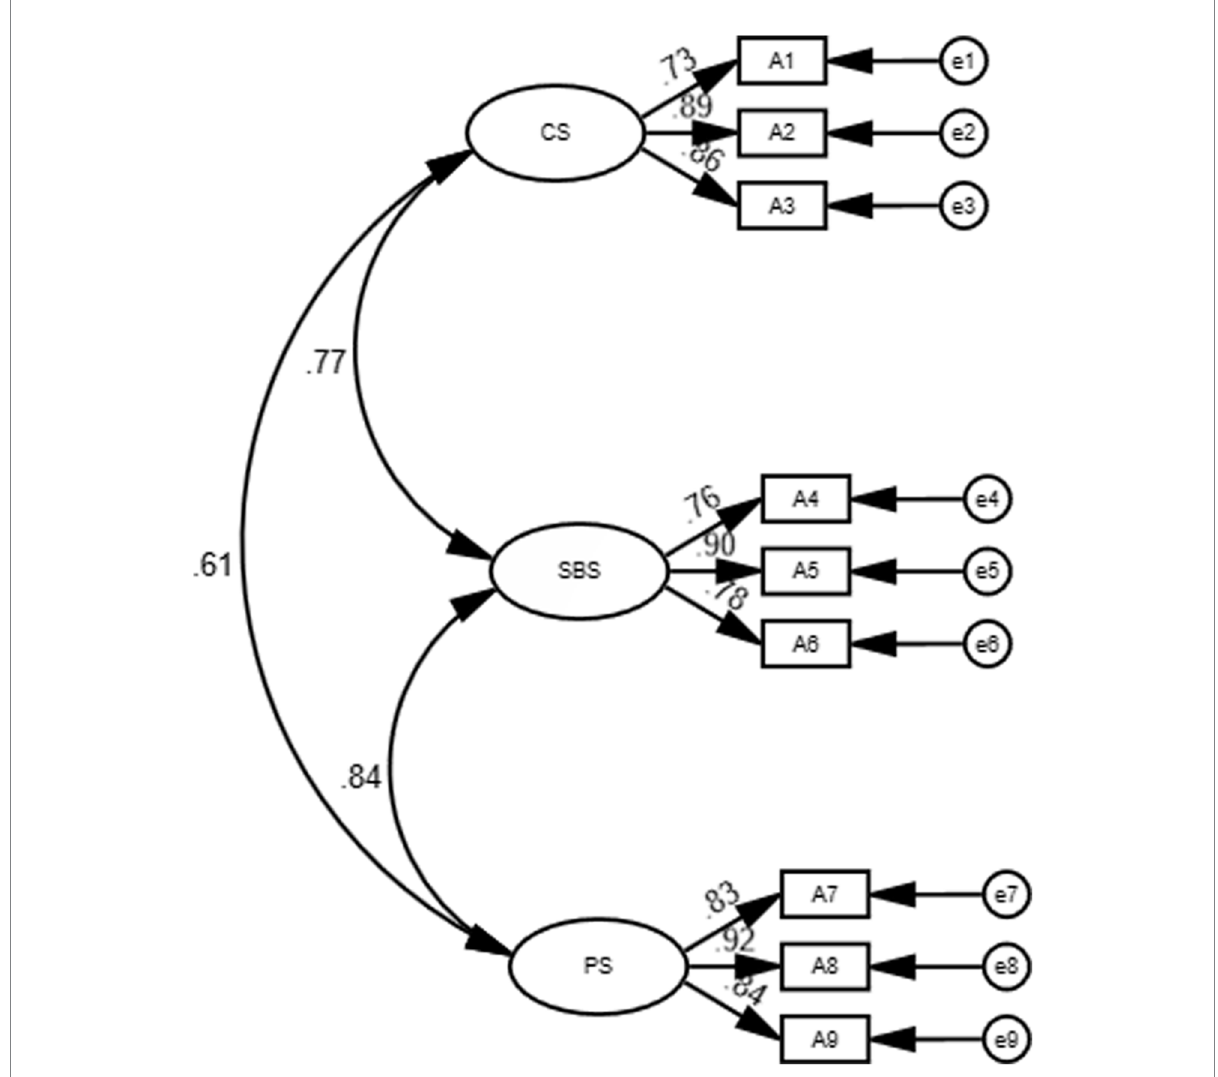
FIGURE 1 PETJSSI three-dimensional model. CS, Colleague Satisfaction; SBS, Student Behaviour Satisfaction; PS, Parent